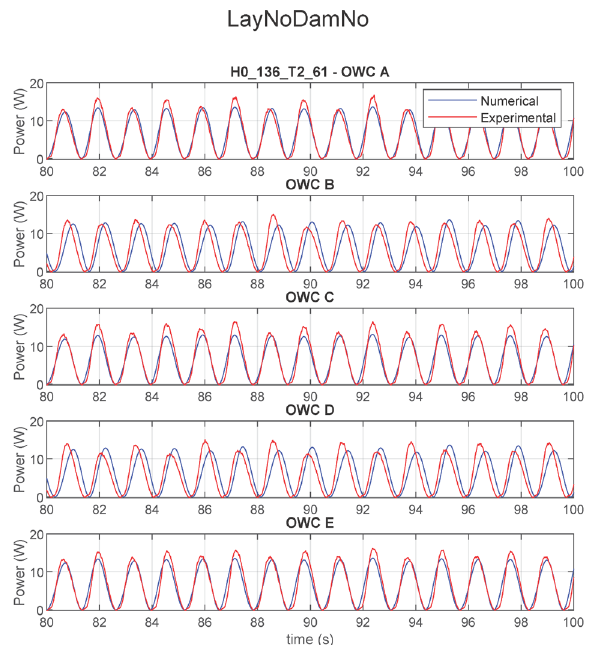
Fig. 7. Comparison of Power time series between experimental and numerical (WEC-Sim) results for a regular wave with Fig. 8. Subplots of average power for each OWC showing a , . Amplitudes track reasonably well, however different period wave input. Top row is non-optimized layout and 𝐻𝐻 = phase lags for OWC B and D, as an offset in bottom row is optimized layout. Bar graph represents average of 0.136 𝑚𝑚 𝑇𝑇 = 2.61 𝑠𝑠 the top row and optimal layout on the bottom row for three bridge positions average power. Error bars show minimum each OWC. Bar graphs show the average of three bridge and maximum average power of the three bridge positions. Error bars show repeatability in the measurements. The average of the positions average power. Error bars show the minimum five average powers for the array is shown in the title. The number and maximum average power of the three bridge in the plot in the lower subplots represents the ratio from non- positions. Average power results show that the OWC optimized to optimized layouts, often called the q-factor. operational range for power production have wave periods of 1.91 s, 2.26 s, and 2.61 s. For the non-optimal layout spatial arrangement of the OWC do not wave propagation through the tank.